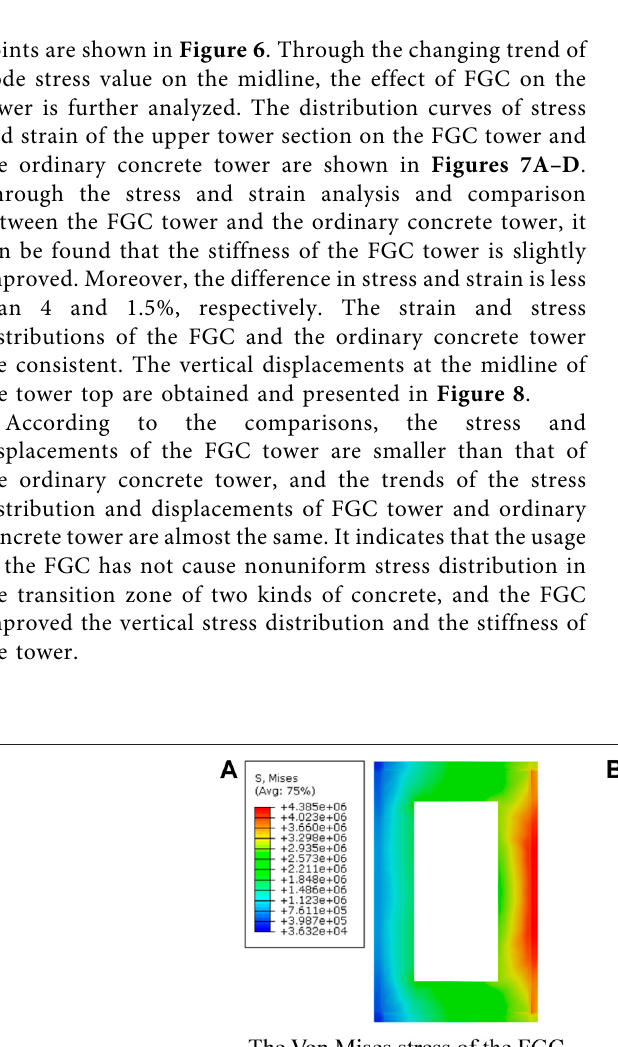
Frontiers in Materials |